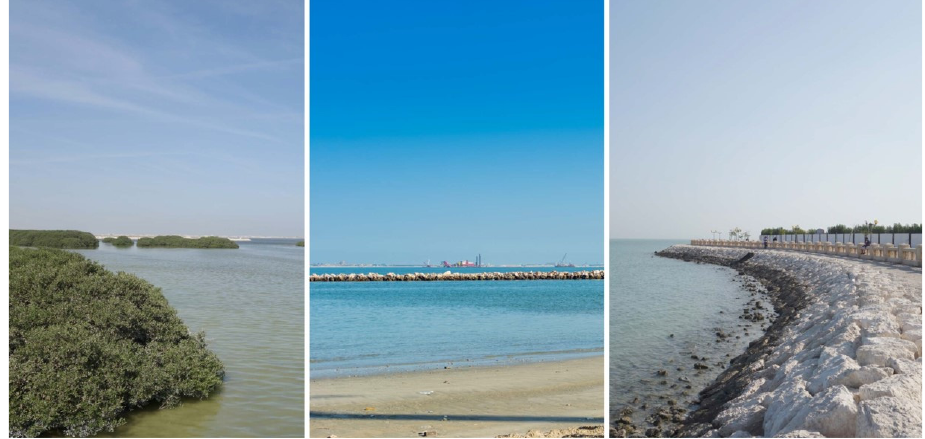
Figure 2. Some examples of the different type of coastlines in DMA, the picture on the left shows the mangrove vegetation on the coastline (Source: [67]).